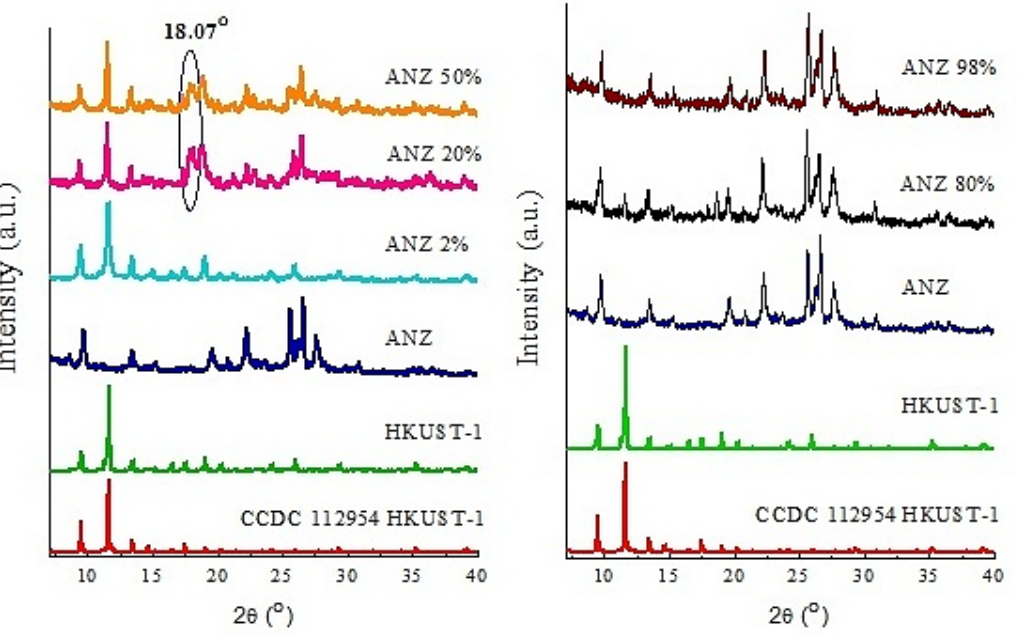
Figure 1 : The diffractograms of HKUST-1, ANZ, and composite ANZ@ HKUST-1 (left) in situ , (right) ex-situ with various ANZ